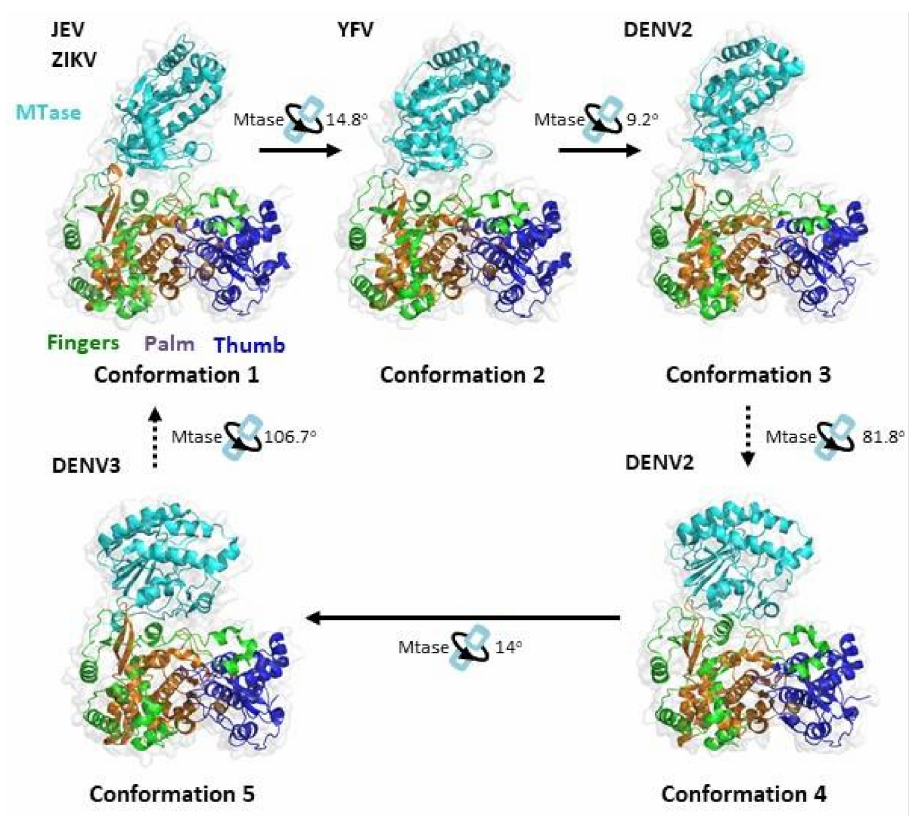
Figure 6. Relationship between the different conformational states of the Flavivirus full-length NS5 structures. The protein structures were obtained from PDB and adapted from [115,118,119,121]. JEV (PDB: 4K6M), YFV (PDB: 6QSN), DENV2 (PDB: 6KR2), DENV2 (PDB: 6KR3) and DENV3 (PDB: 4V0Q). Ribbon representations show the arrangement of the MT and RdRp domains of NS5. The MTase is coloured in cyan, the RdRp fingers in green, the RdRp palm in brown and the RdRp thumb in blue. The conformational changes between the protein structures were analysed using the DynDom database